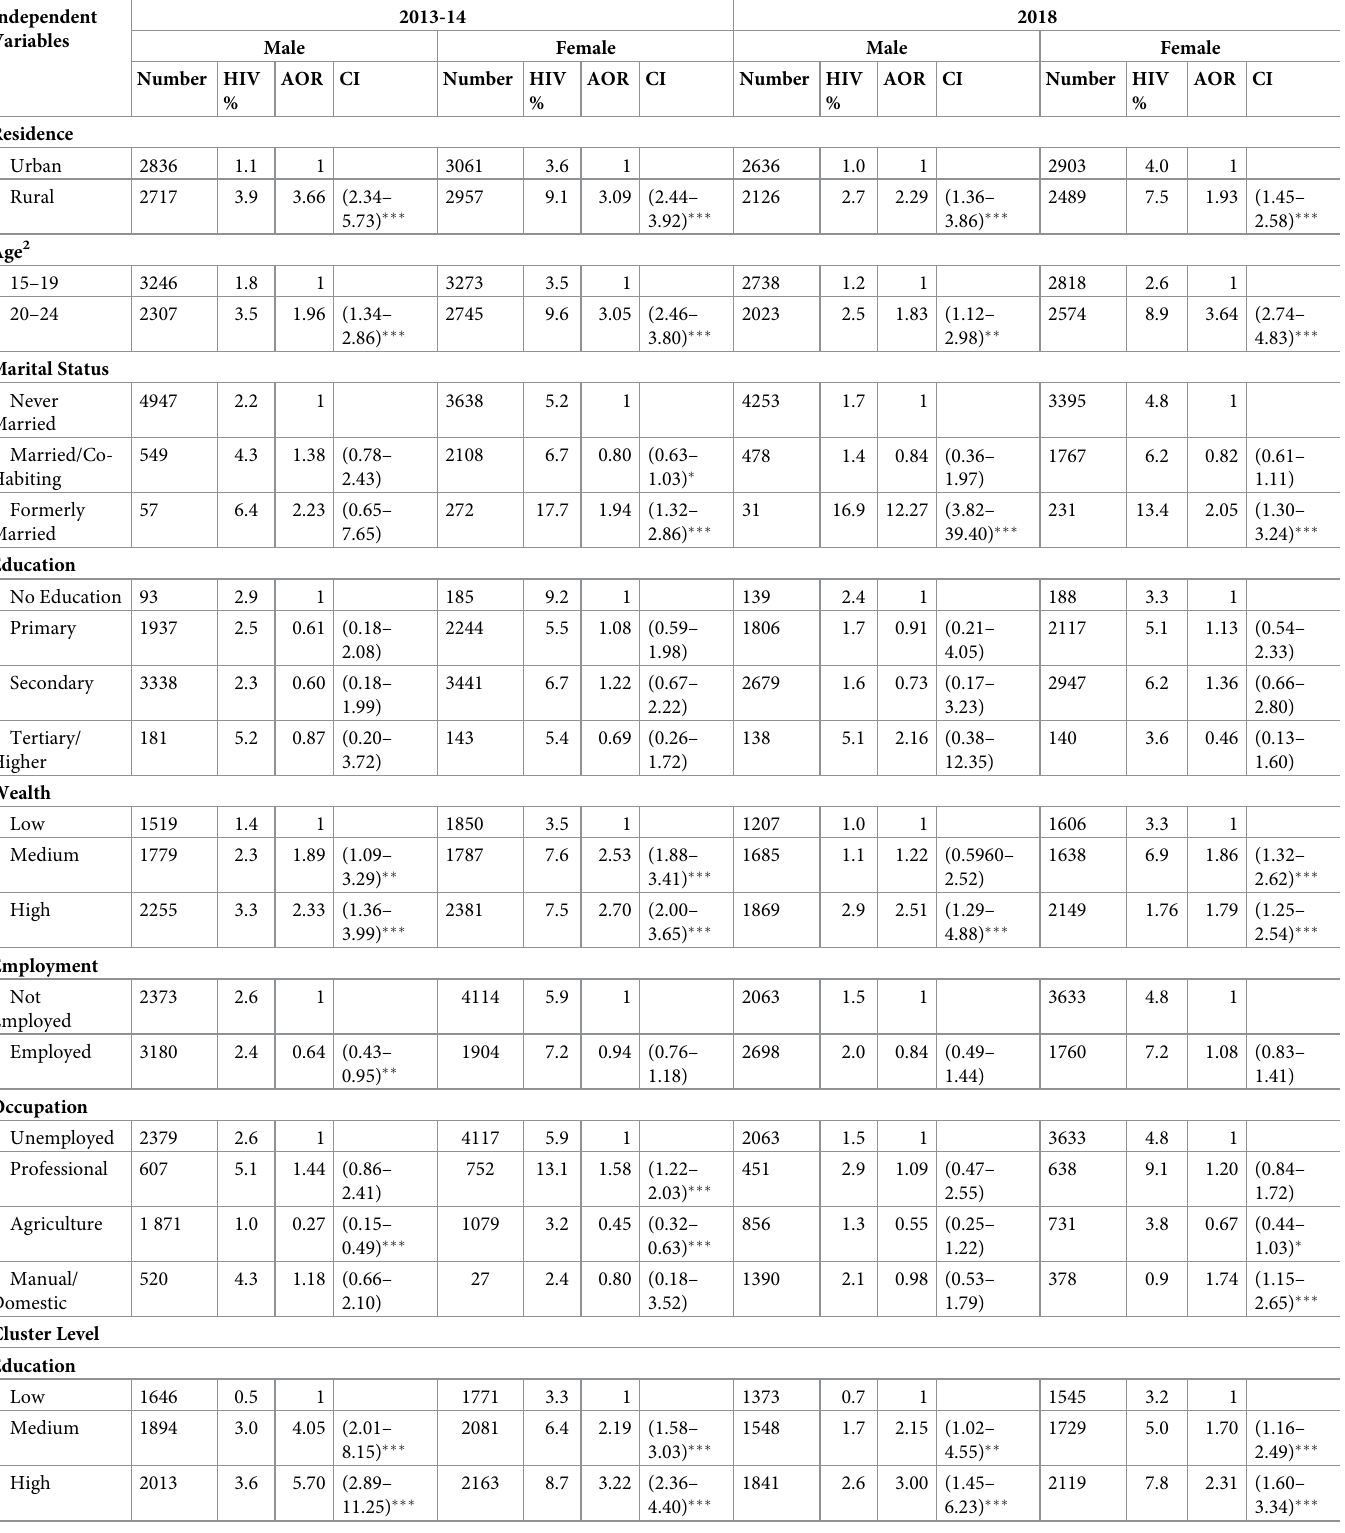
Table 2. HIV prevalence and age-adjusted odds ratios by background characteristics and sex among young people 15–24 years, 2013–14 and 2018,